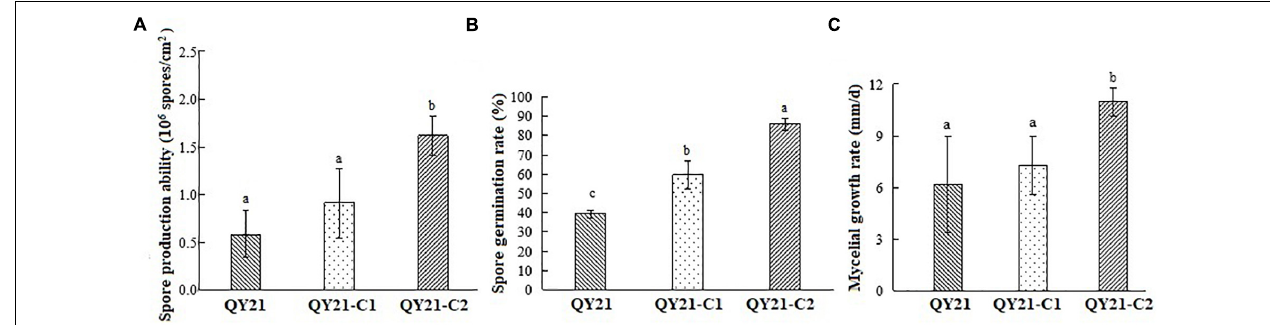
FIGURE 5 | Biological comparison of the co-infected strain QY21 and the isogenic virus-cured strains QY21-C1 and QY21-C2. The strain QY21 is doubly infected with AaCV1-QY2 and AaMV1; the strain QY21-C1 has eliminated the virus AaMV1 and retains the virus AaCV1-QY2; QY21-C2 strain has completely eliminated all viruses and is virus-free. (A) The number of spores produced by the strains QY21, QY21-C1, and QY21-C2 (PDA, 7 days, 25 ◦ C). (B) Spore germination rate (PDA, 25 ◦ C). (C) Radial mycelial growth rate (PDA, 25 ◦ C). Different letters indicate a significant difference at p < 0.05 according to the post hoc t -tests.